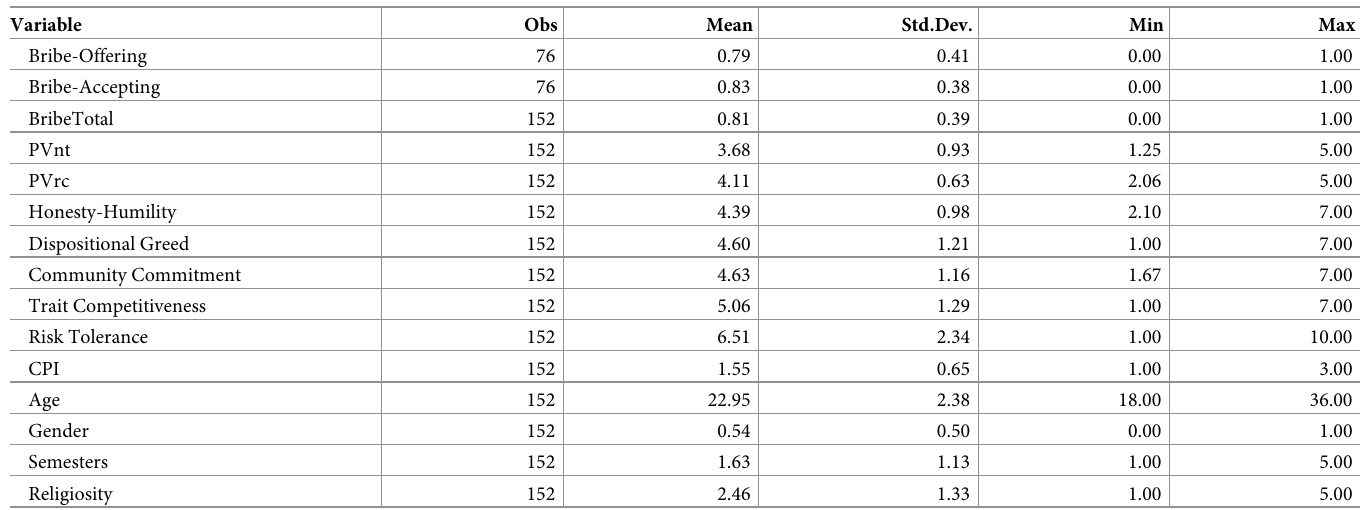
Table 1. Summary statistics.